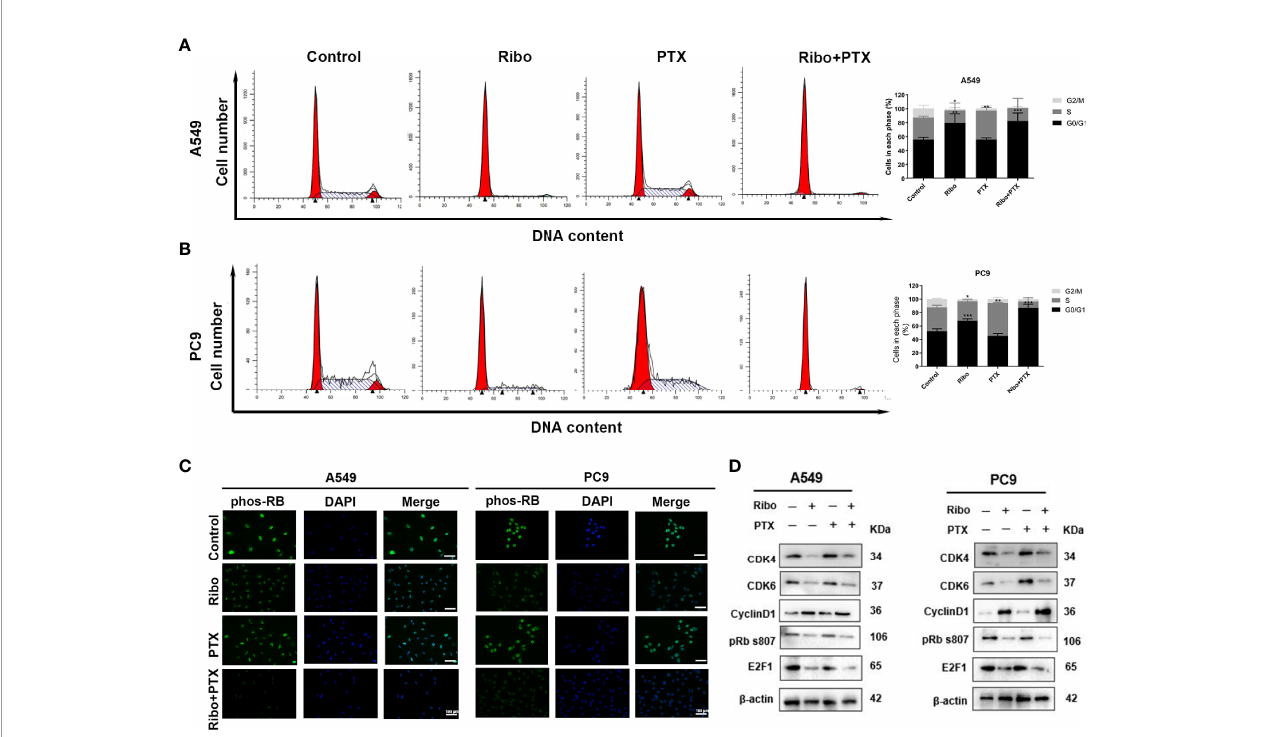
FIGURE 4 | The effect of ribociclib and pemetrexed on cell cycle in A549 and PC9 cells. (A, B) The cell cycle distribution of A549 and PC9 cells treated with ribociclib and pemetrexed alone or in combination. (C) The expression and subcellular localization of pRB were detected using immuno fl uorescence analysis in A549 and PC9 cells. (D) Western blotting showed the changes in levels of cyclin D1, CDK4/6, pRB, and E2F1. The scale bars represent 100 m m. Data are presented as mean ± SD of triplicate experiments (*p < 0.05, **p < 0.01, and ***p < 0.001). SD, standard